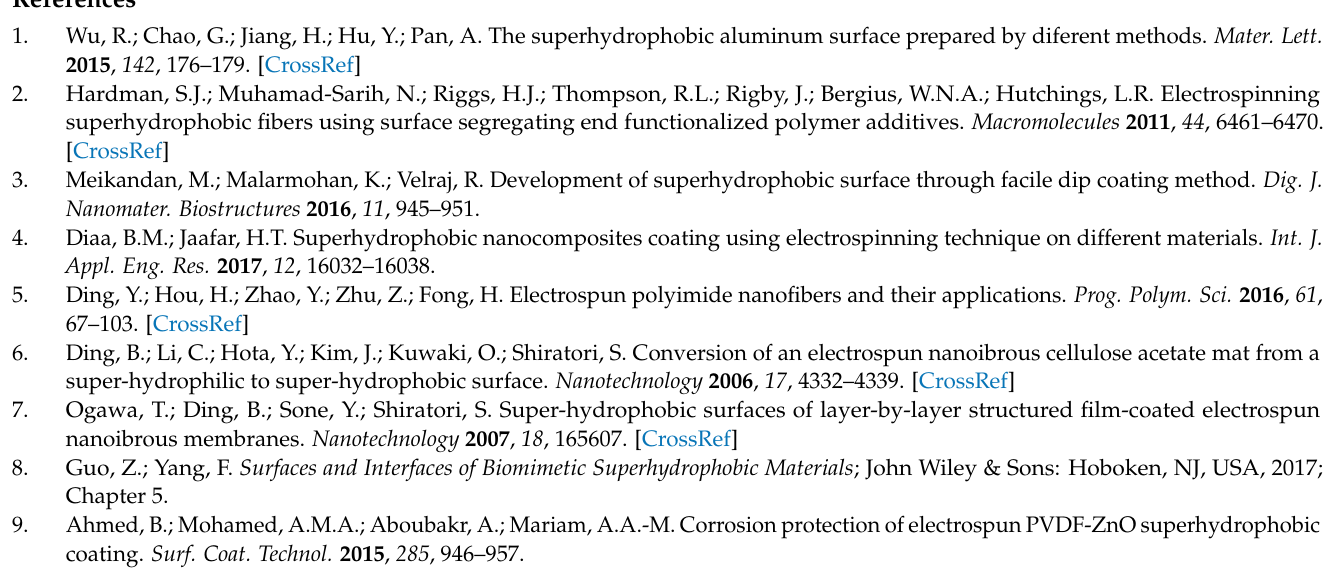
trospun fibers. Table S2: Water contact angle obtained for aligned electrospun fibers. Figure S1: Scanning electron microscope (SEM) image of randomly distributed electrospun fibers. The inset is the enlarged image of the fiber diameter. Figure S2: Scanning electron microscope (SEM) image of randomly distributed electrospun fibers. The inset is the enlarged image of the fiber